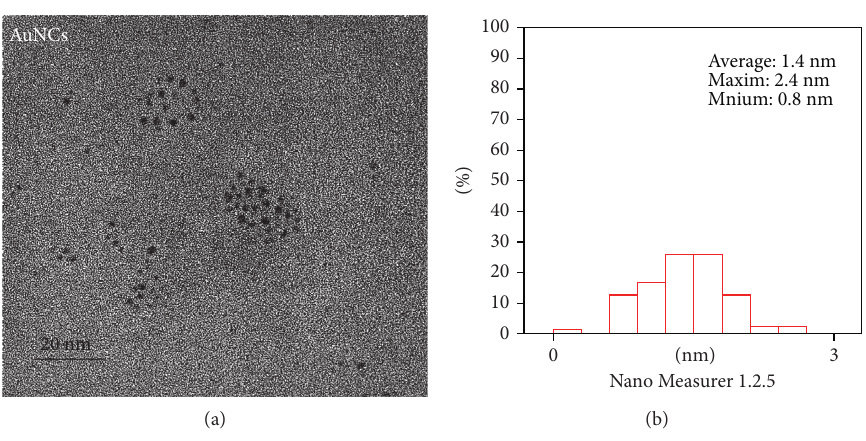
Figure 2: TEM of the original GSH-protected